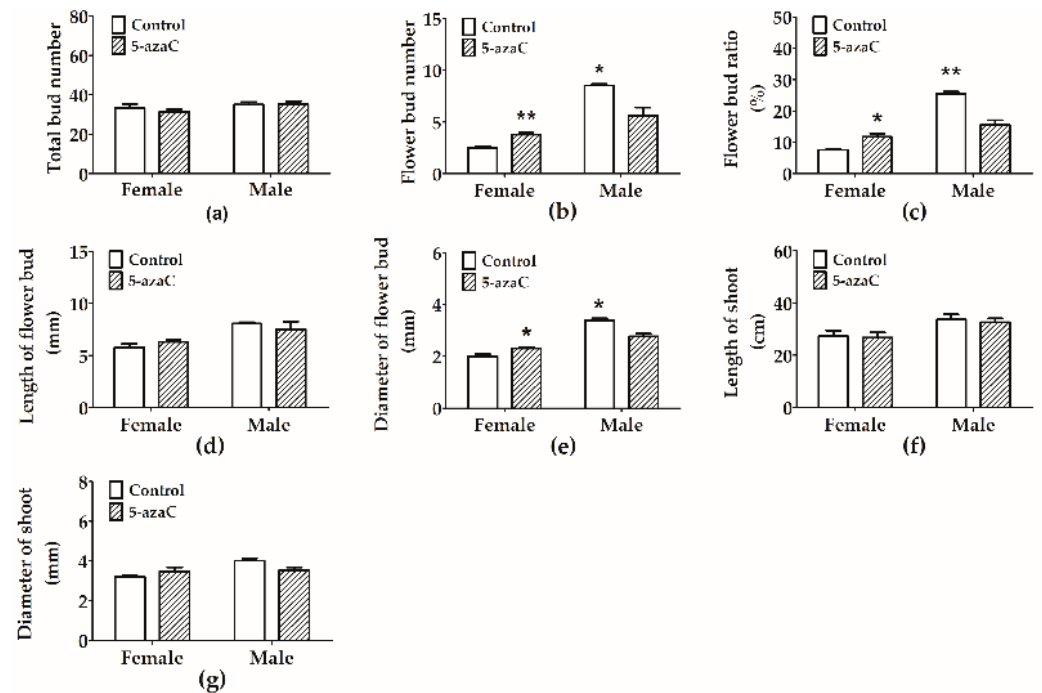
Figure 2. Development of flower buds and annual shoots in male and female plants treated with 5-azaC. ( a ) Total (vegetative and floral) bud numbers in the annual shoots. ( b ) Flower bud numbers in annual shoots. ( c ) The ratio of flower buds to total buds in annual shoots. ( d ) Length of flower buds. ( e ) Diameter of flower buds. ( f ) Length of annual shoots. ( g ) Diameter of annual shoots. Least significant difference (LSD) tests were used to determine any significant differences between the treatment and control groups. Data are mean ± SE, n = 3. *, Significant difference between treatment and control ( p < 0.05); **, significant difference between treatment and control ( p < 0.01).